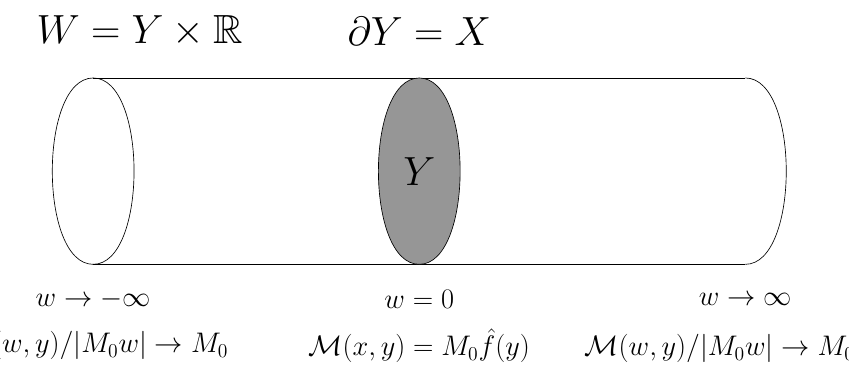
Figure 3 . We define a ( d + 2) -dimensional non-compact manifold W as W = Y × R . On W , the d -dimensional mass matrix M ( x ) = M 0 f ( x ) on X is extended to M ( w, y ) , which has the specifically chosen asymptotic behavior as w → ±∞